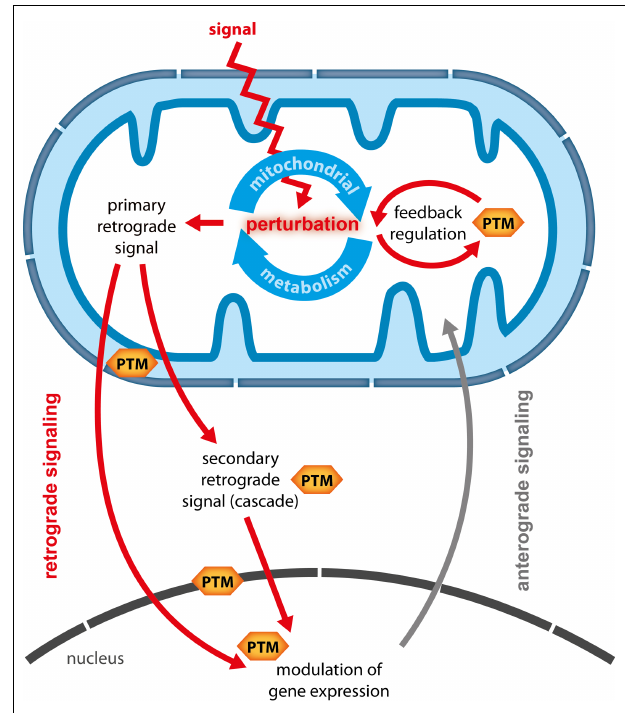
FIGURE 1 | Potential functions of PTMs in mitochondrial retrograde signaling. When an external signal or stress causes perturbations in mitochondrial metabolism several responses are possible and PTMs could contribute on multiple levels. (1) Mitochondrial metabolism is adapted via feedback regulation, during which PTM catalyzing enzymes could alter enzymatic activity in response to changes in metabolic status. (2) Metabolic intermediates are generated as primary retrograde signals, which either travel directly to the nucleus, or which are perceived at the mitochondrial boundary or in the cytosol and then translated into secondary signals or signaling cascades. PTMs are likely to be involved in the generation and transduction of such secondary signals. Moreover, PTMs could transduce signals across the inner mitochondrial or the nuclear membrane. In the nucleus PTMs of histones, transcription factors or transcriptional complexes could translate mitochondria-derived signals into specific changes in gene